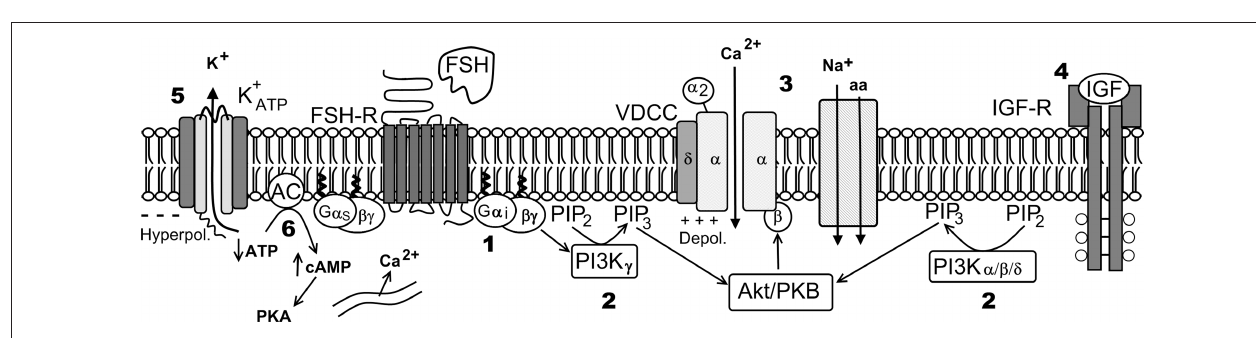
FiGure 9 | Hypothetical model of FSH action on Ca 2 + uptake and amino acids transport. Numbers indicate pharmacological agent effects on different steps of the FSH action: 1 – PTX blocks Gi protein; 2 – Wortmannin blocks PI3K; 3 – Verapamil inhibits Ca 2 + uptake and amino acid transport; 4 – JB1 and anti-IGF-I antibody block IGF-I action but not the